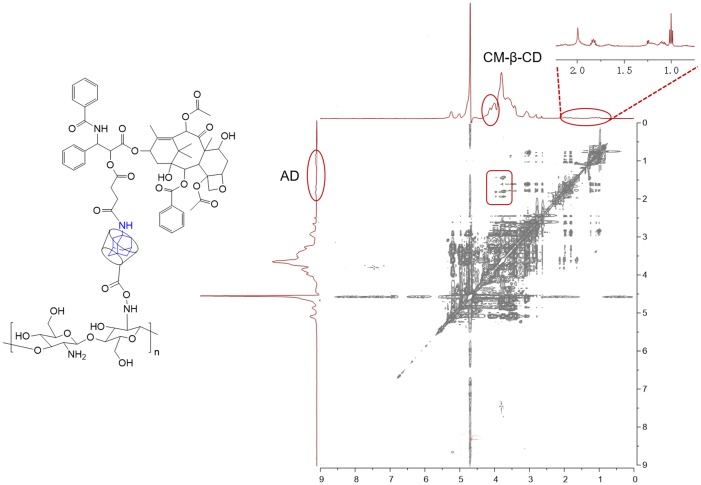
2D-NOESY NMR spectrum of CSO-g-CM-β-CD@AD-PTX in D2O.